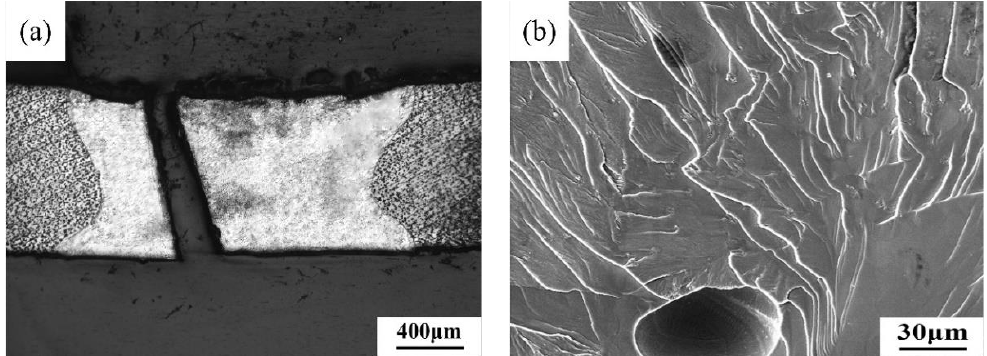
Figure 12. The fracture path ( a ) and fracture surface morphology ( b ) of the joint without filler metal.